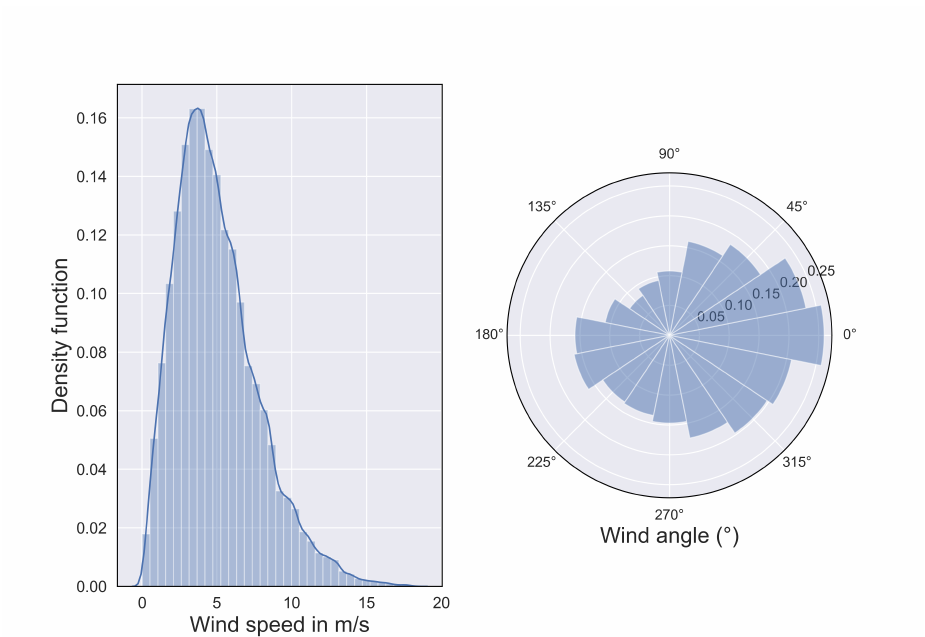
Figure 5. Normalized histograms and density functions of the mean wind velocity and the mean wind direction across wind maps of the training base. Left: density function (blue curve) of wind velocity norm in m/s with the normalized histogram. Right: normalized histogram of wind direction in degrees.